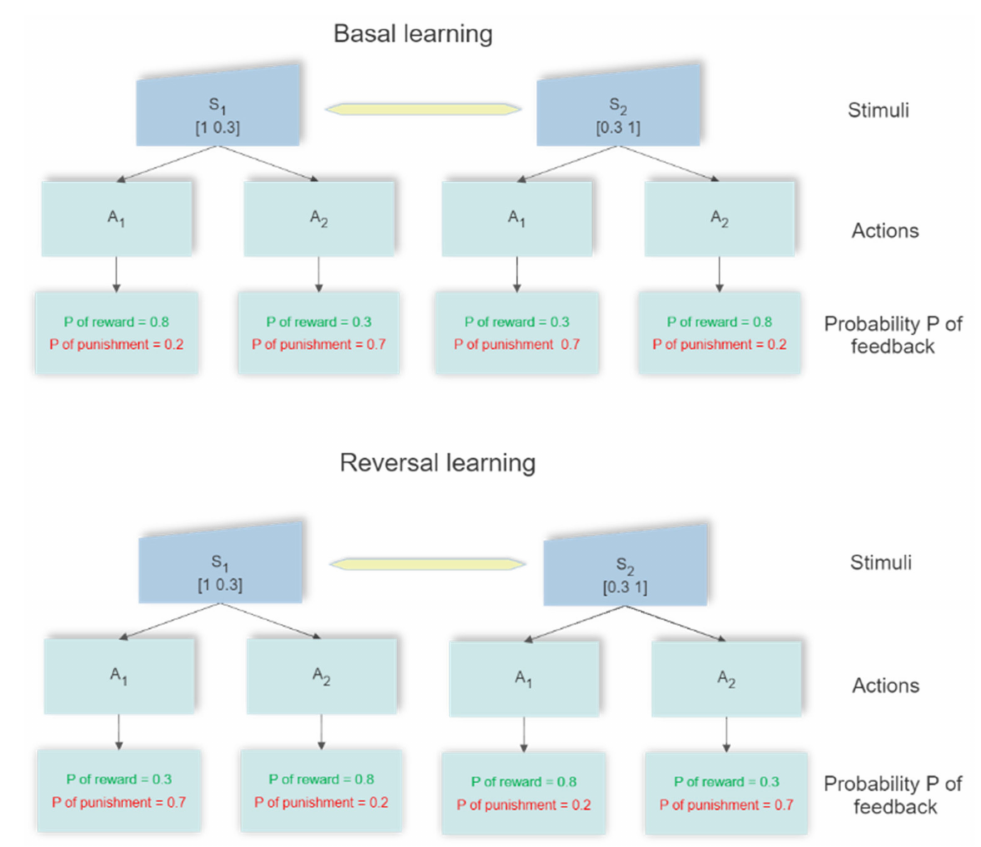
Figure 13. Training design of two-choice experiment. The upper panel refers to the basic learning phase: after the presentation of the stimulus S 1 , the first action (in this case A 1 ) has a probability P of 0.8 to be rewarded (otherwise punished), whereas the second action A 2 is rewarded with a probability of 0.3 (otherwise punished). When a stimulus S 2 is given, the reward feedback probabilities are 0.3 and 0.8 for A 1 (first action) and A 2 (second action), respectively. The thick arrow between the stimuli S 1 and S 2 indicates the random permutation. It is worth noting that action A 1 is more frequently rewarded for the stimulus S 1 , and action A 2 for the stimulus S 2 , during basal training. The bottom panel gives a schematic representation of the reversal learning phase: when S 1 is presented, action A 1 receives a positive feedback with a probability of 0.3 (otherwise punished), whereas the probability of reward for the second action A 2 is 0.8 (otherwise punished); after S 2 presentation, A 1 and A 2 are rewarded with a probability of 0.8 and 0.3, respectively, (otherwise punished). During reversal learning, the second action (A 2 for the stimulus S 1 and A 1 for the stimulus S 2 ) refers to actions with reward probabilities as high as 0.8, i.e., the more frequently rewarded